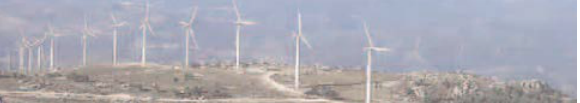
Figure 7. Fly-through of turbines simulating the previsible visual impact. The photogram of the animated sequence has been processed later using Photoshop tools in order to provide a more realistic